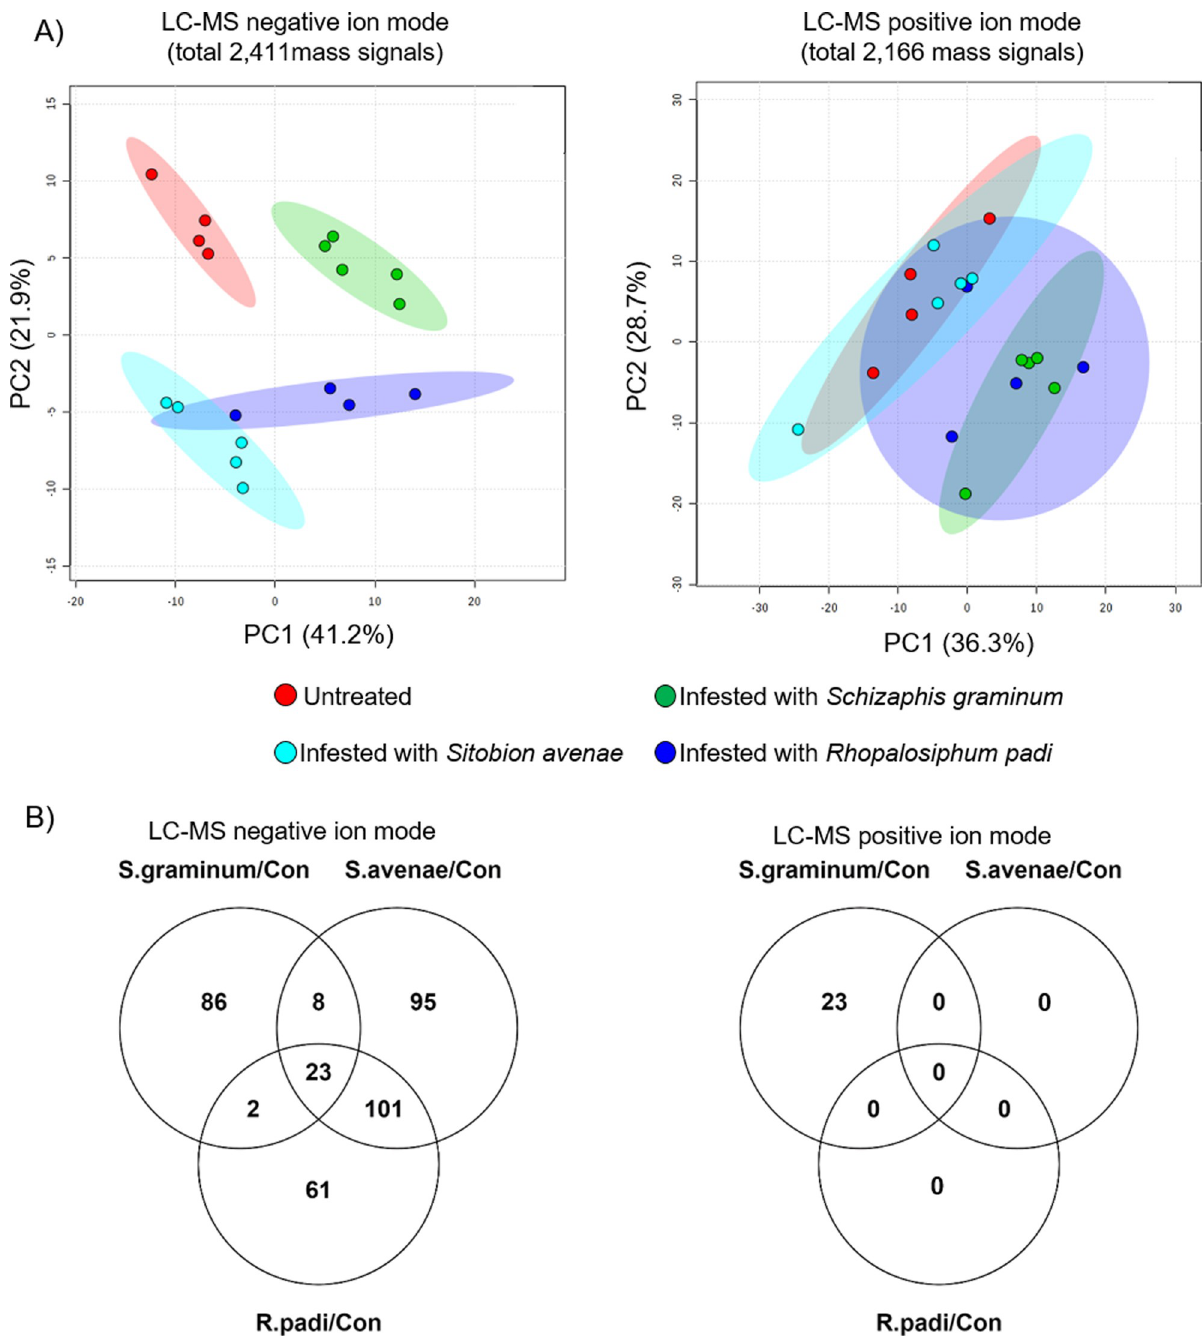
Fig 2. An untargeted metabolic overview of durum wheat infested with S . graminum , S . avenae and R . padi for 96 hr. A) PCA plots of features from negative (2,411 ESI) and positive (total 2,166 ESI) ion modes illustrated by using Metaboanalyst software (n = 4–5). B) Venn diagram illustrating the number of total features significantly up- or down-regulated by cereal aphid treatment; negative ion mode (left) and positive ion mode (right). P value < 0.05 FDR and fold change > 2 or <